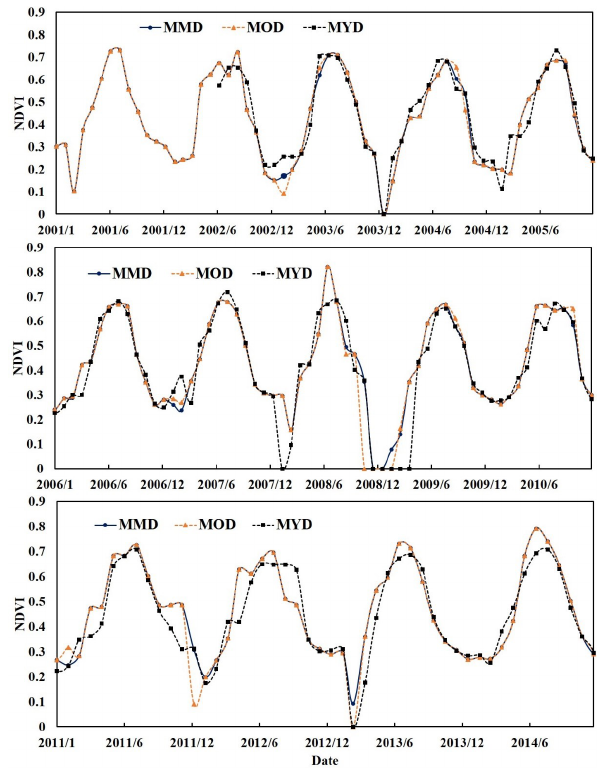
Figure A3. Comparison of three NDVI monthly time series over one